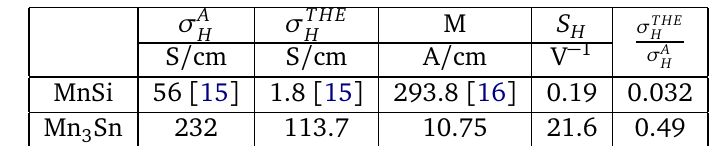
Figure S7: An example of the extraction of B Table S3: A comparison of magnetization and AHE in Mn 28